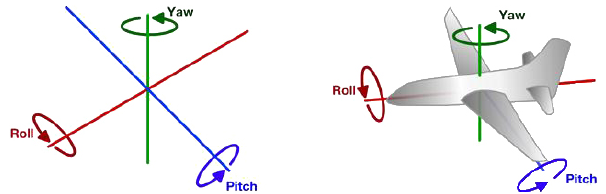
Figure 10. Model of the aircraft maneuvers performed during the FOM test (source: modified from http://www.thevoredengineers. com/2012/05//the-quadcopter-basics, free